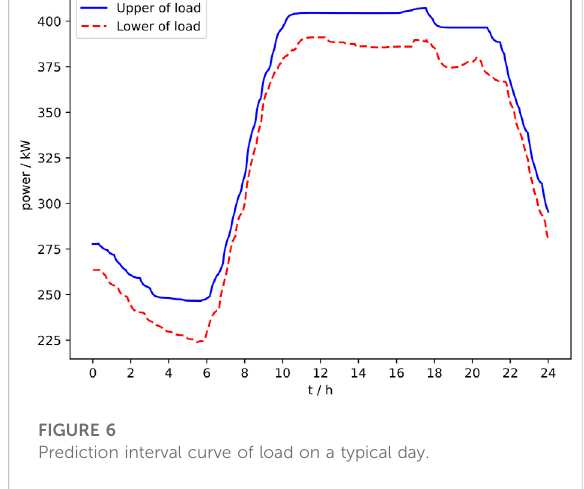
FIGURE 6 Prediction interval curve of load on a typical